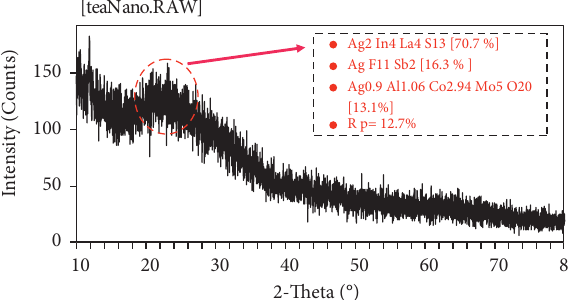
Figure 3: XRD analysis of Camellia sinensis silver nanoparticles.